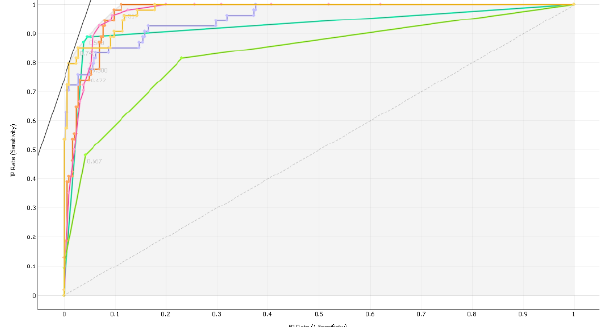
Fig. C2. ROC curve analysis relating to class “Satisfactory”